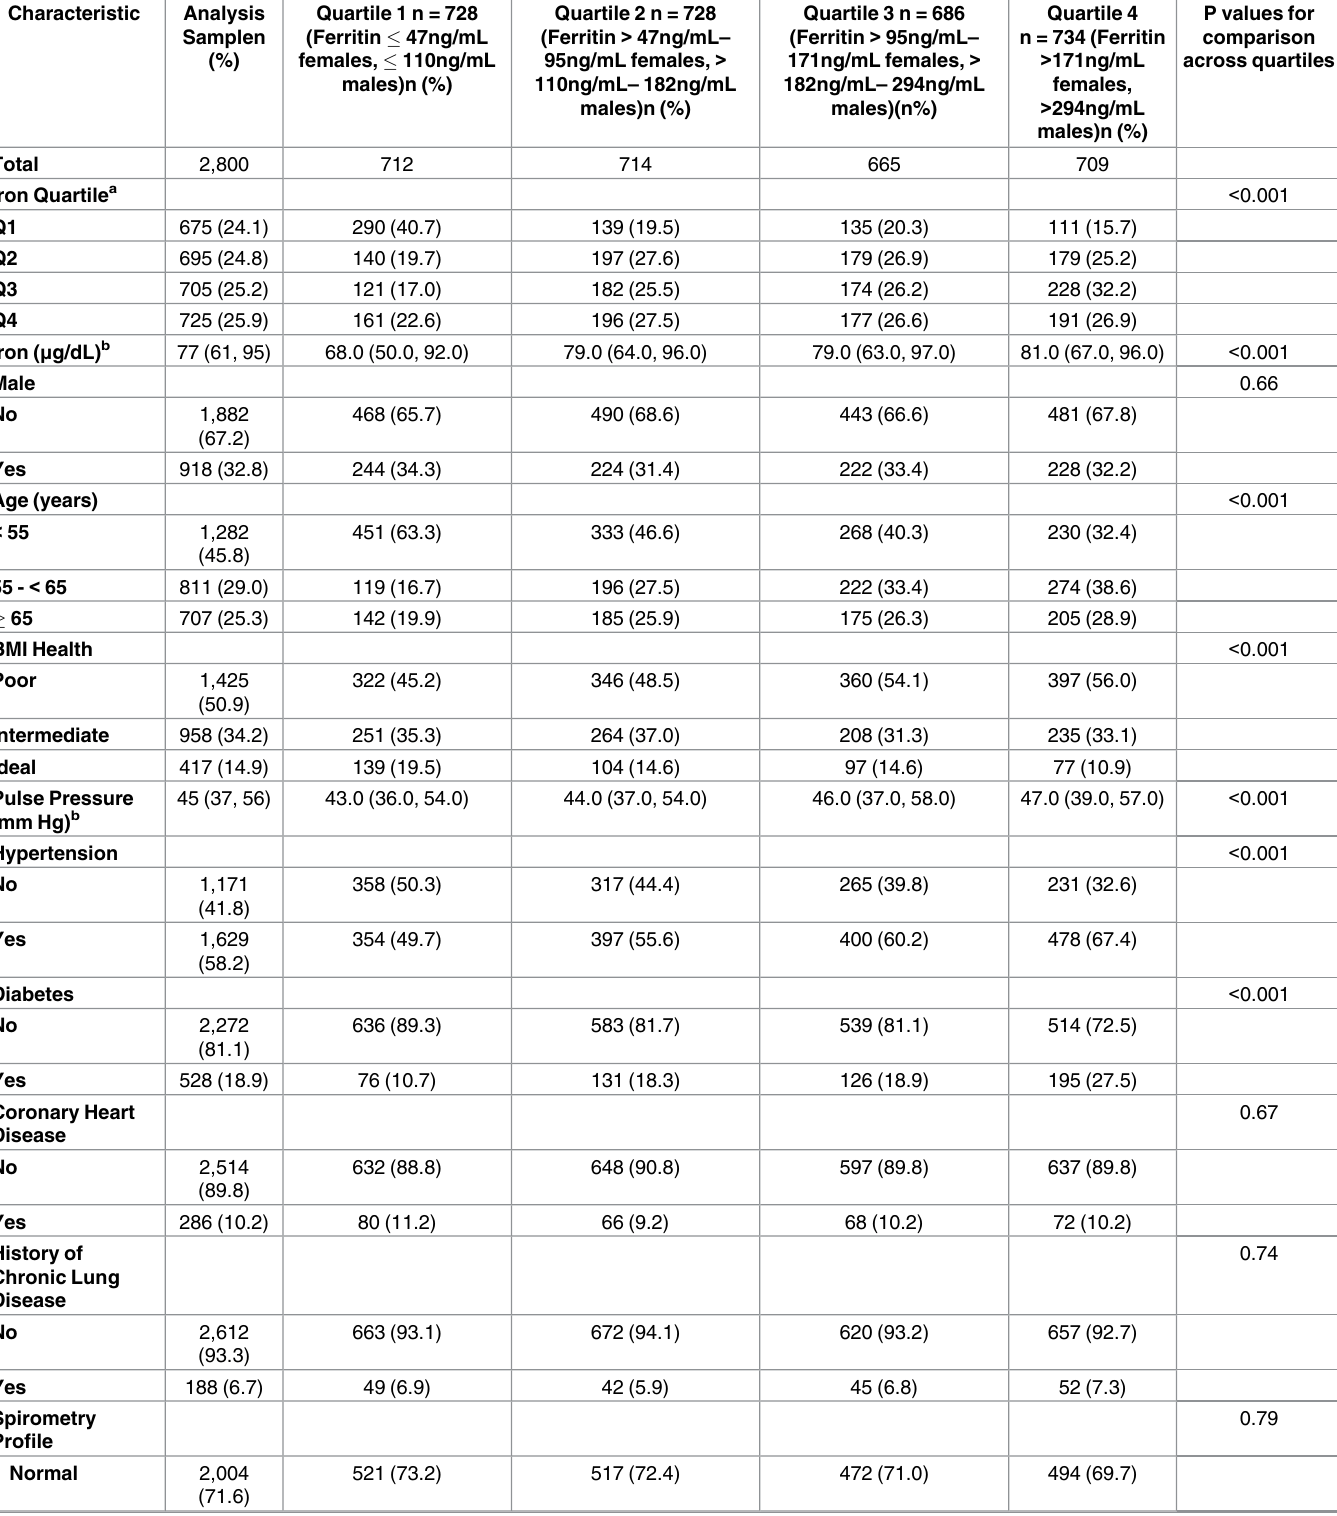
Table 1. Baseline demographics of the analysis sample and stratified by quartiles of ferritin.